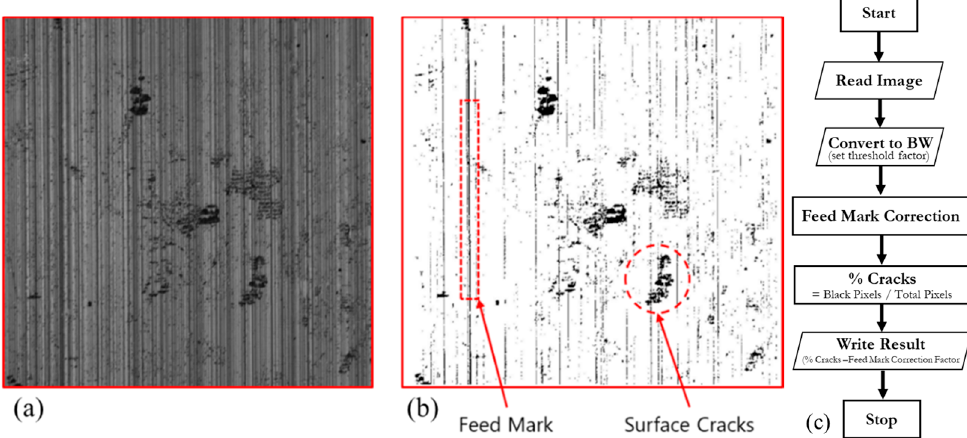
Figure 6. ( a ) Surface image with cracks at 21 µm DOC using a sharp carbide tool, ( b ) processed image output with MATLAB crack script, and ( c ) MATLAB script